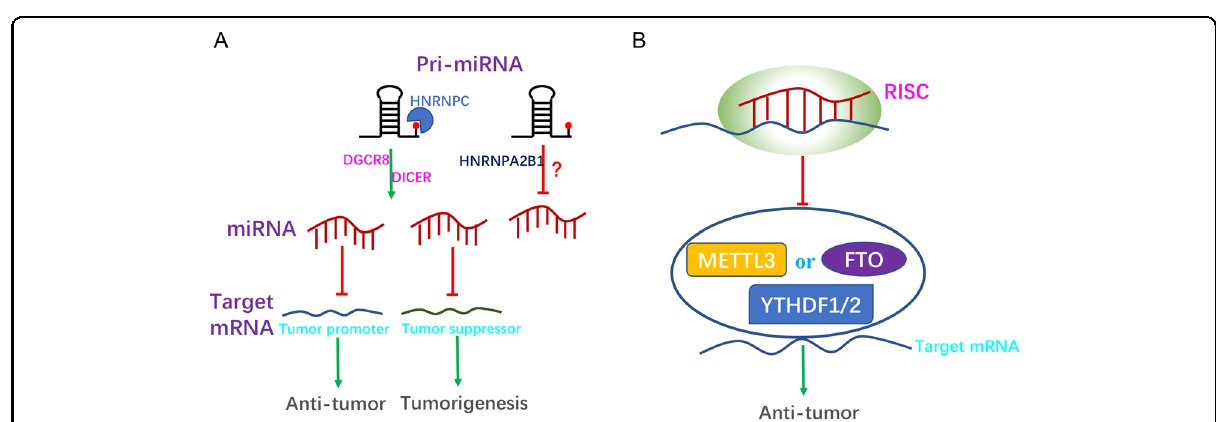
Fig. 3 Interaction between m6A and miRNAs in cancer. A m6A modi fi cations play different roles in multiple cancers by in fl uencing the maturation of miRNAs. m6A modi fi cation promotes miRNA maturation by recruiting DGCR8 to promote pri-miRNA processing or increasing pre- miRNA splicing by Dicer in different cancers. Furthermore, m6A modi fi cation can promote or inhibit the occurrence and development of tumors by affecting the maturation of miRNAs. HNRNPA2B1 has also been found to inhibit the shearing of some of the pri-miRNAs; however, the speci fi c mechanism underlying this inhibition remains unclear in breast cancer. B miRNAs affect cancer progression by regulating m6A modi fi cation of mRNAs ( METTL3, FTO, YTHDF1, and YTHDF2 ).